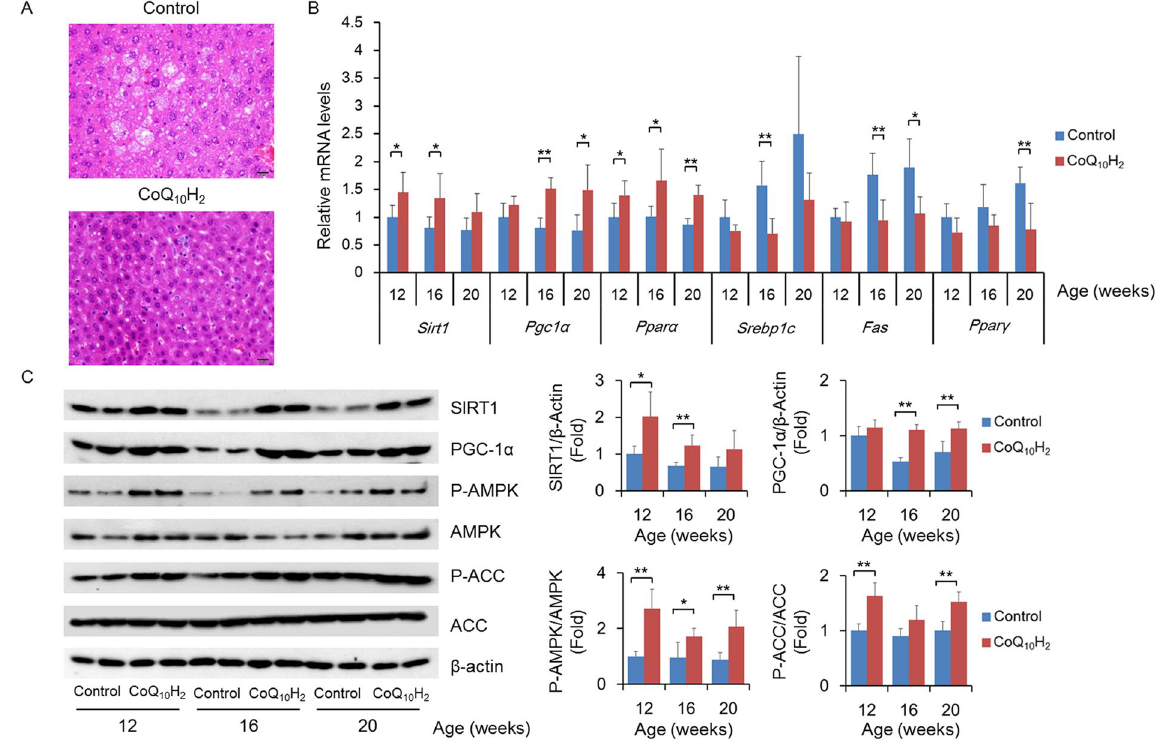
Figure 3. CoQ 10 H 2 improves cAMP levels and promotes lipid metabolism in the livers of KKAy mice. ( A ) Images of liver tissue stained with H&E in 20-week-old KKAy mice. Bar = 50 μ m; ( B ) Changes in gene expressions for factors involved in triglyceride and cholesterol biosynthesis or lipid mobilization and mitochondrial function in 12-, 16-, and 20- week-old KKAy mice in the control and CoQ 10 H 2 groups as determined by real-time PCR. Histograms show fold-change in mRNA level relative to 12-week-old control KKAy mice. (n = 4–6, ∗ p < 0.05, ∗∗ p < 0.01 mean ± SD, Student’s t-test); ( C ) Protein content of SIRT1 and PGC-1 α and phosphorylation levels of AMPK and ACC in the livers of KKAy mice were measured by Western blotting. All blots were obtained under the same experimental conditions, and cropped images of the blots are shown. Densitometric quantification is depicted on the right panel. (n = 4–6, ∗ p < 0.05, ∗∗ p < 0.01; mean ± SD, Student’s